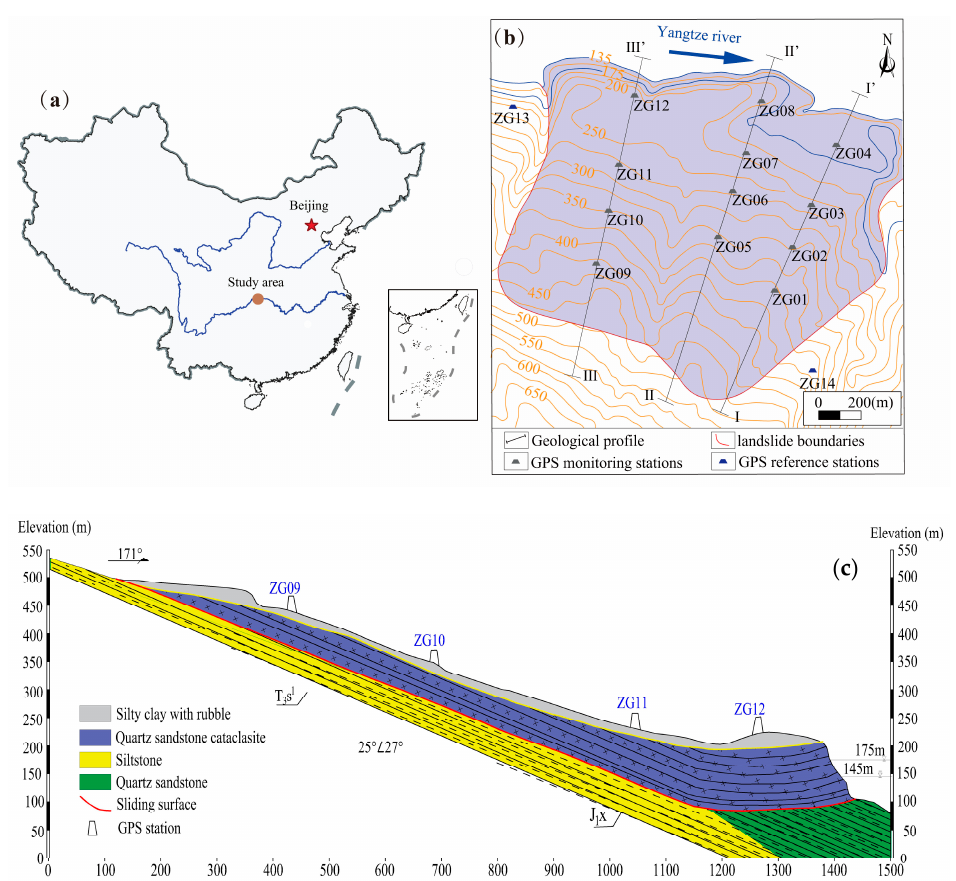
Figure 4. ( a ) The location of the study area in China; ( b ) the monitoring network of the Muyubao landslide; ( c ) the geological profile III-III’ of the Muyubao landslide.